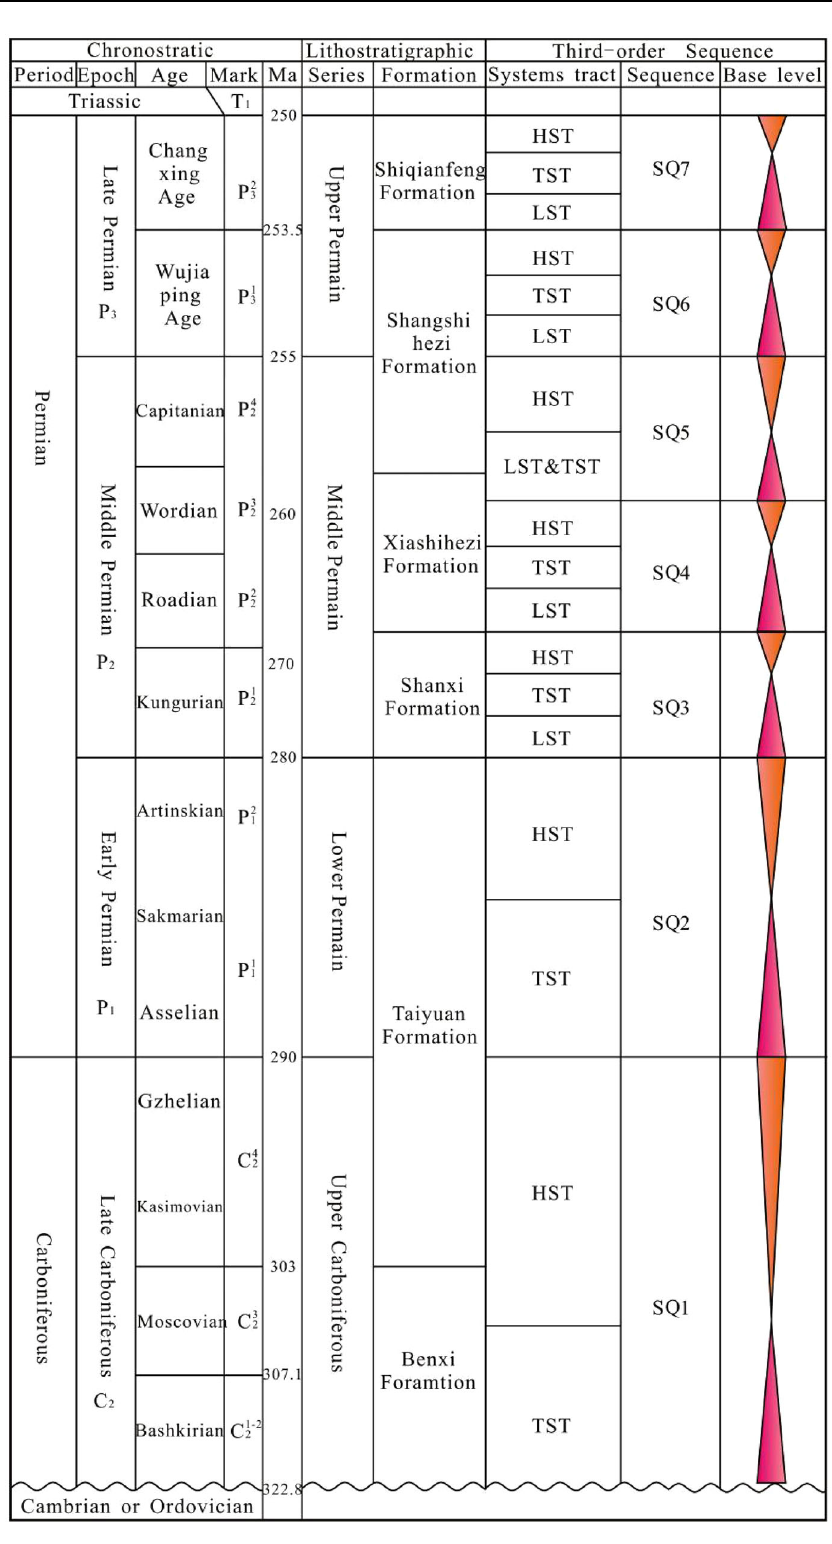
Fig. 4 Sequence stratigraphic framework of the Carboniferous-Permian coal-bearing strata in the North China coal-accumulating area (revised after Shao et al.